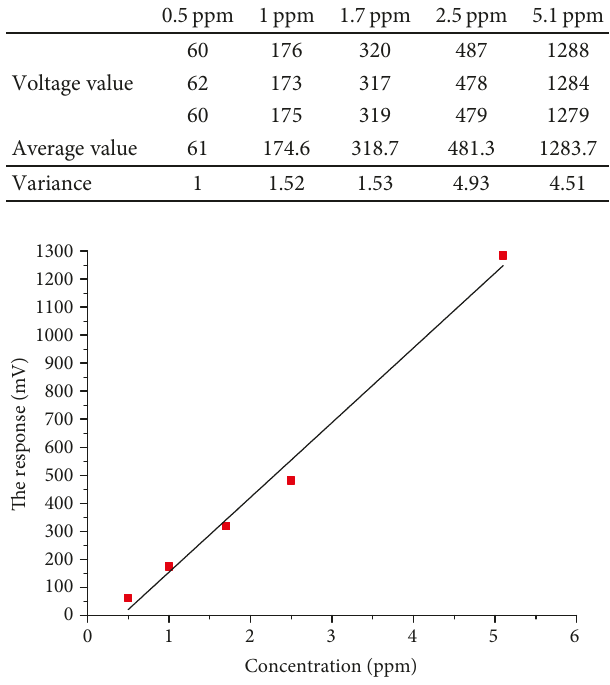
Figure 9: The e ff ect of gas concentration on response